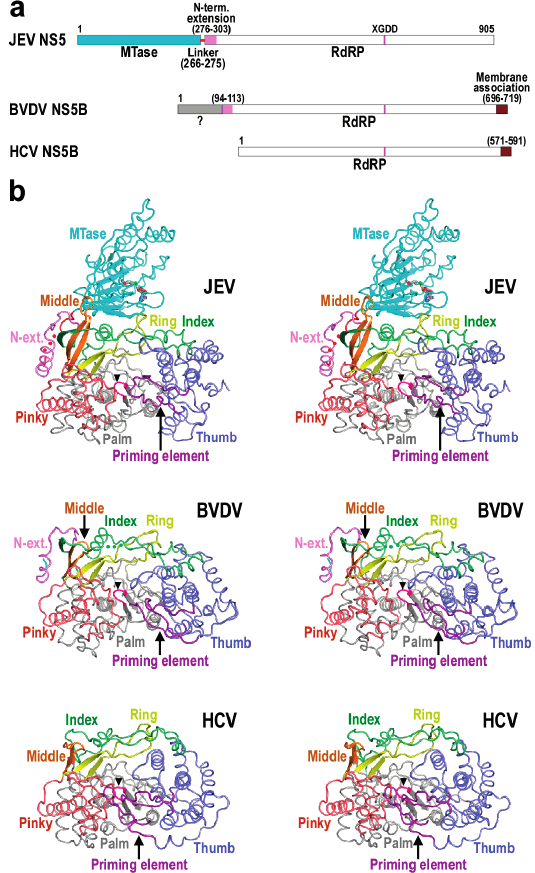
Figure 1. Structural comparison of representative Flaviviridae RdRPs. ( a ) A schematic of Flaviviridae RdRPs defining functional regions; ( b ) Stereo-pair images of Flaviviridae RdRP structures (pdb entries: 4K6M, 1S4F and 1NB4) viewing down into the polymerase active site. The RdRP signature sequence XGDD is shown in magenta (also indicated by a black triangle). Red dots in the JEV structure indicates disordered residues 271–273 in the MTase-RdRP linker and the S -adenosyl- L -homocysteine (SAH) bound in the MTase domain is shown as sticks. In the BVDV structure, residues 92–127 from a second molecule are connected to the C-terminal part of the protein by the green dots to present the likely canonical fold. Structures were superimposed using program THESEUS